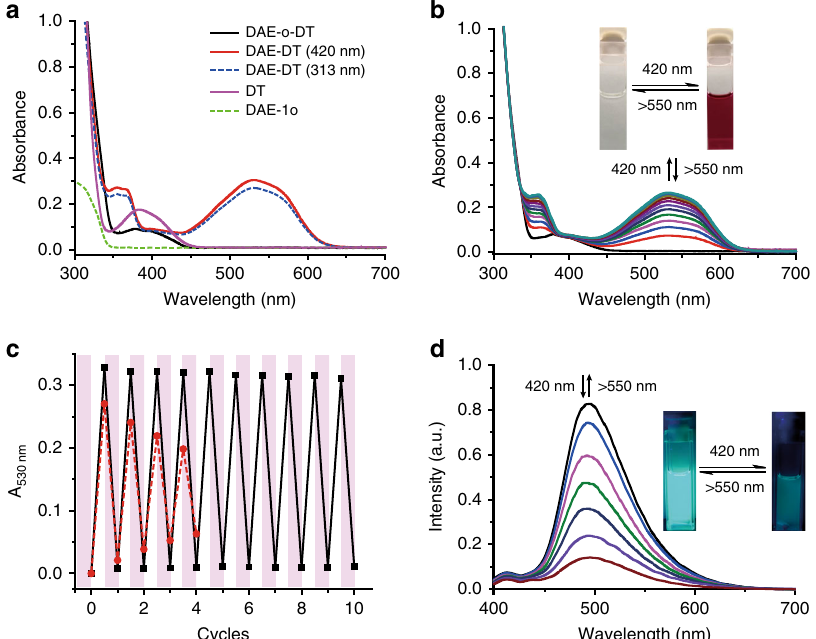
Fig. 2 Photochromic properties of the visible-light-driven DAE-o-DT in solution. a Absorption spectra changes of DAE-o-DT (2.0 × 10 − 5 M) in deaerated toluene before (black) and after irradiation with 313 nm (blue dash) and with 420 nm (red solid); absorption spectra of DT (4.0 × 10 − 5 M, purple) and DAE-1o (1.0 × 10 − 5 M, green dash). b The photochromic performance of DAE-o-DT (2.0 × 10 − 5 M) under alternate 420 nm/>550nm irradiation. Insets: photographs of color changes of DAE-o-DT in deaerated toluene before and after irradiation. c Absorbance of DAE-DT (2.0 × 10 − 5 M) in PSS at 530 nm in deaerated toluene during repetitive switching cycles consisting of alternate 420 nm/>550nm irradiation (triplet excitation, black) and 313 nm/>550nm irradiation (singlet excitation, red). Irradiation was carried out by an Hg/Xe lamp (200 W) equipped with a narrow band interference fi lter for λ = 420 nm and a broad band interference fi lter for λ > 550 nm. d The photoswitchable fl uorescence performance of DAE-DT (2.0 × 10 − 5 M) under alternate 420 nm/ >550 nm irradiation. Insets: photographs of fl uorescence changes of DAE-DT in deaerated toluene before and after irradiation